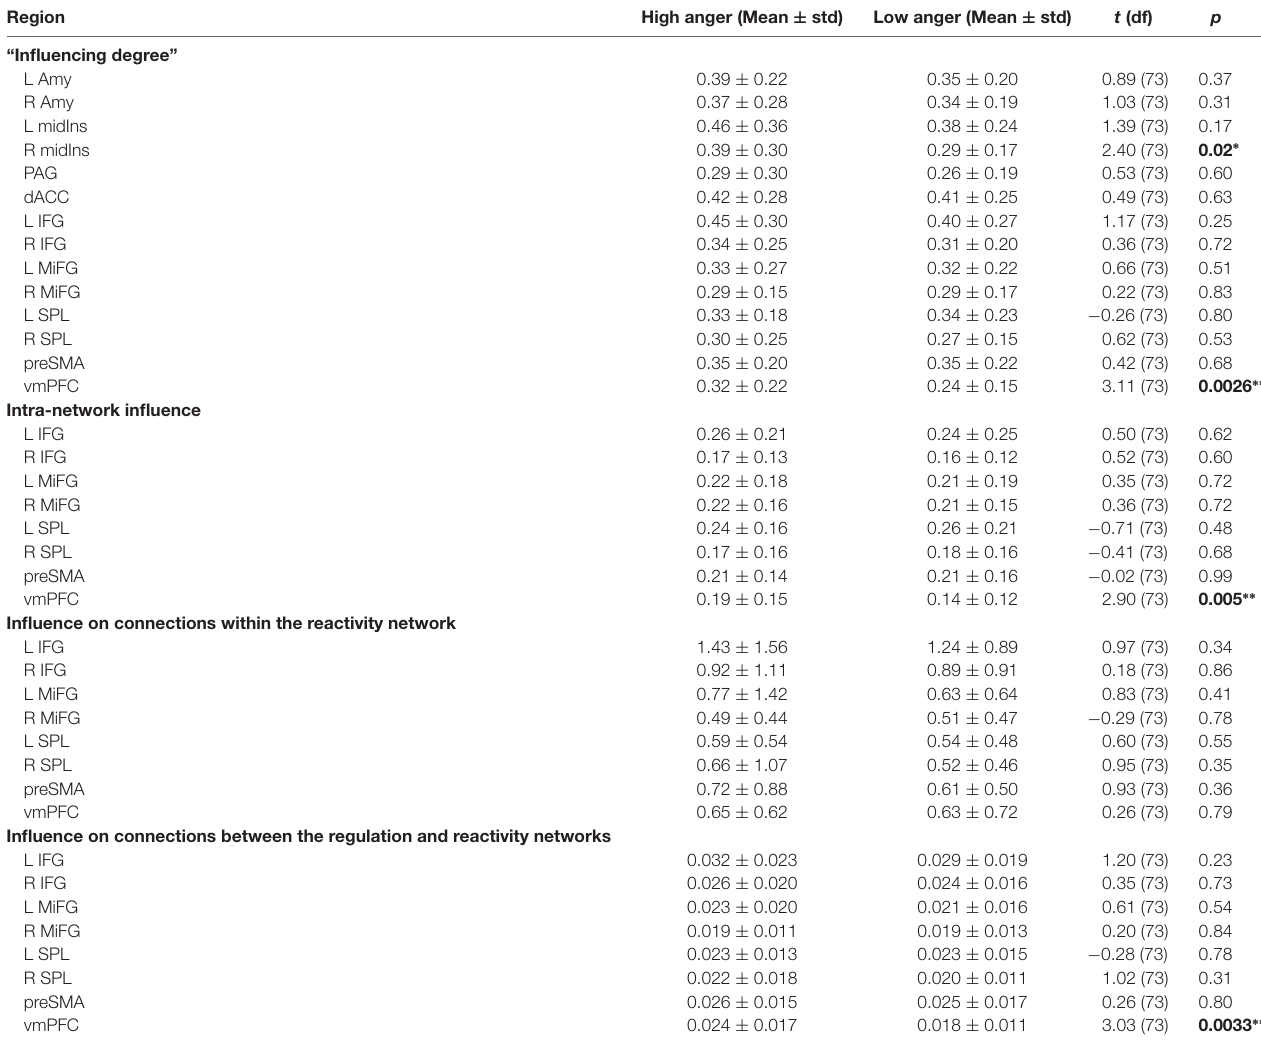
TABLE 1 | High vs. low anger conditions t -test results.